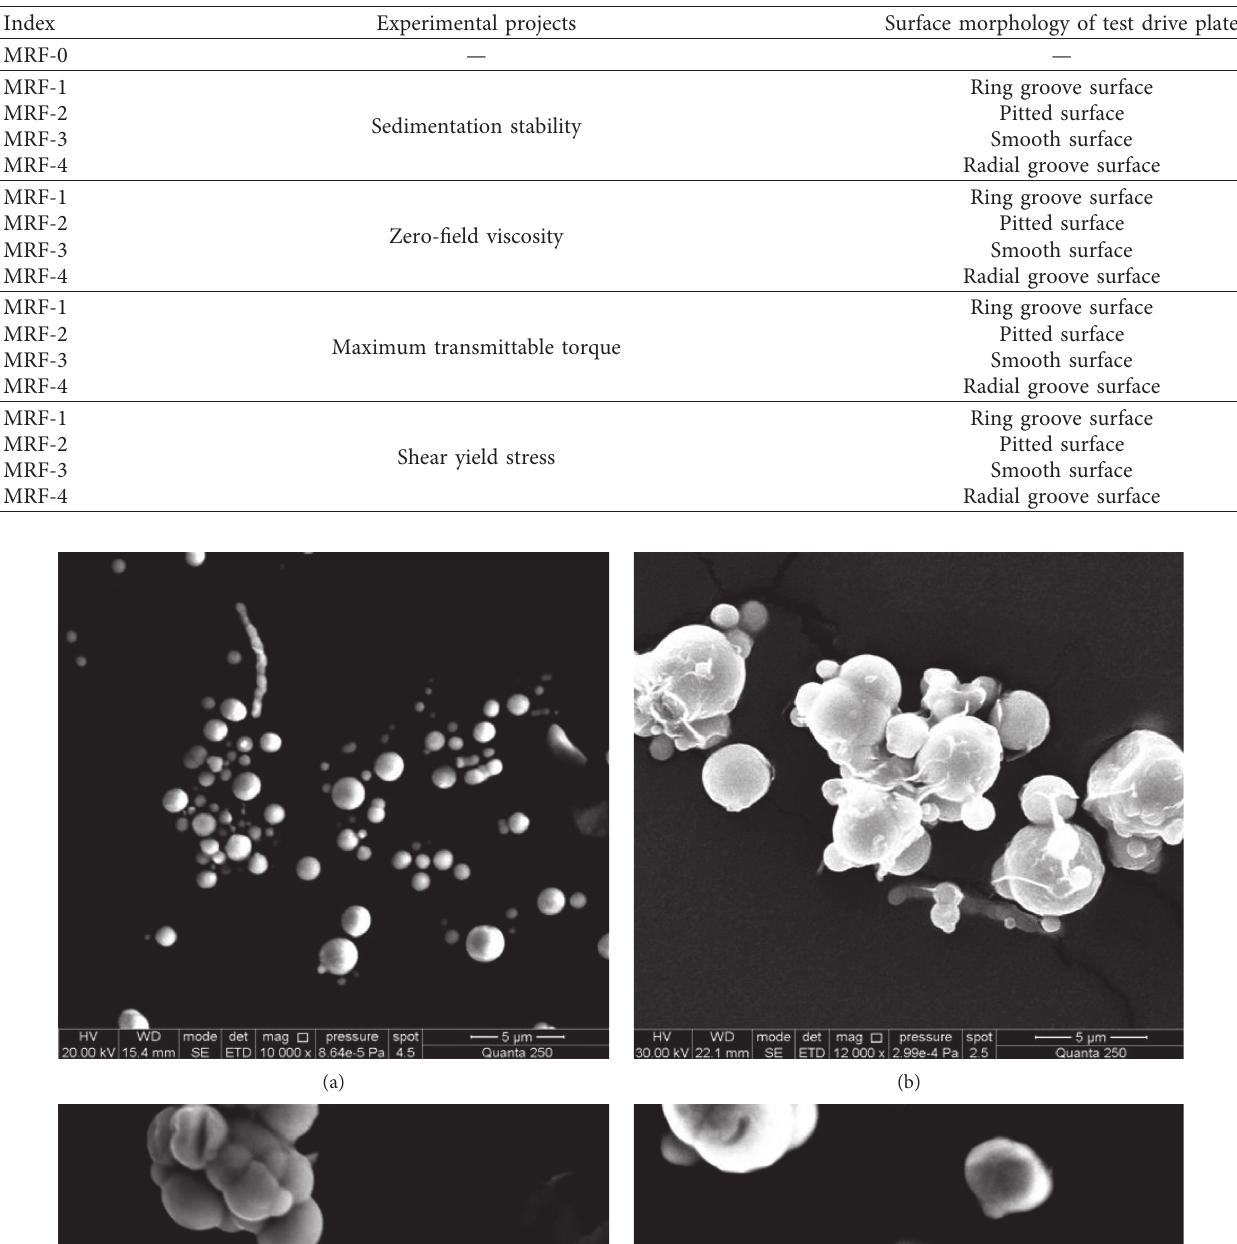
Table 1: Index of MRF samples and the corresponding test drive plate.